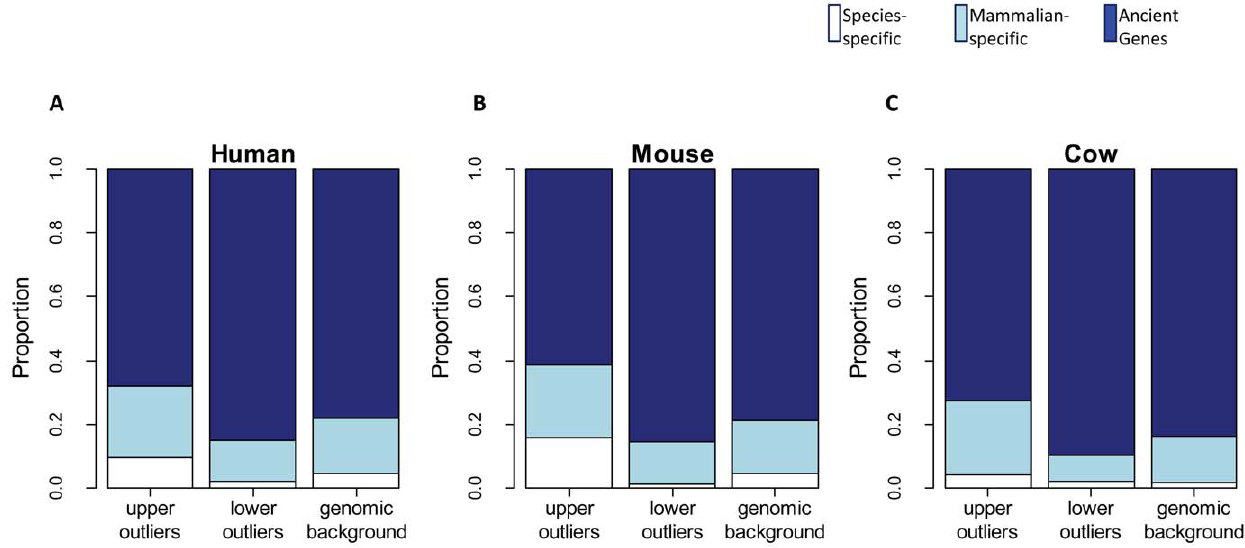
Figure 2. TE density and conservation level of outlier genes. Patterns for human, mouse and cow are shown in (A), (B) and (C), respectively. Proportions corresponding to different gene conservation levels for each gene set are shown as a stacked bar, with the color scheme for species- specific, mammalian-specific and ancient genes indicated at the top.